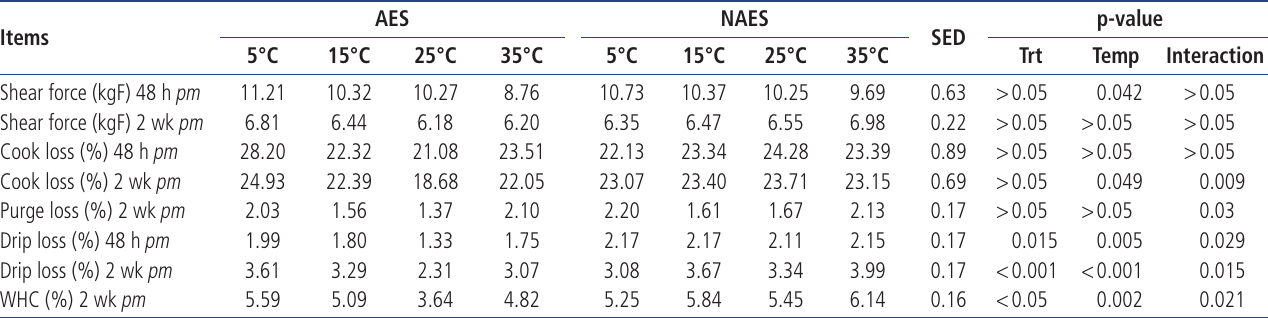
AES, electrical stimulation; NAES, no additional electrical stimulation; SED, standard error of difference; WHC, water-holding capacity; 2 wk, 2 weeks; pm, post mortem (n =